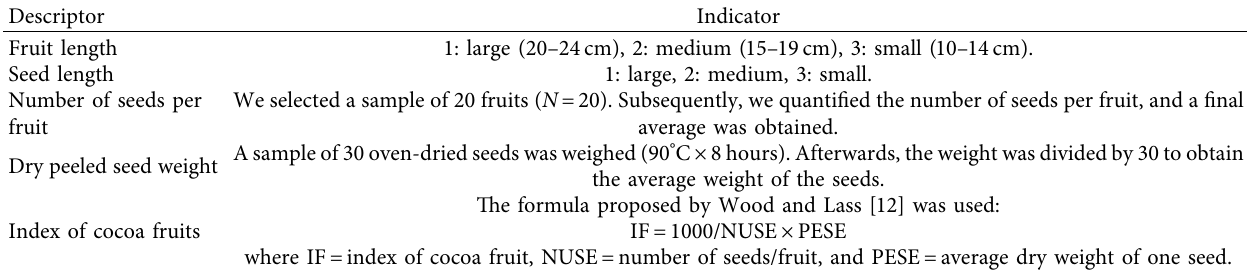
Table 2: Productivity descriptors of fine-flavor native cocoa.